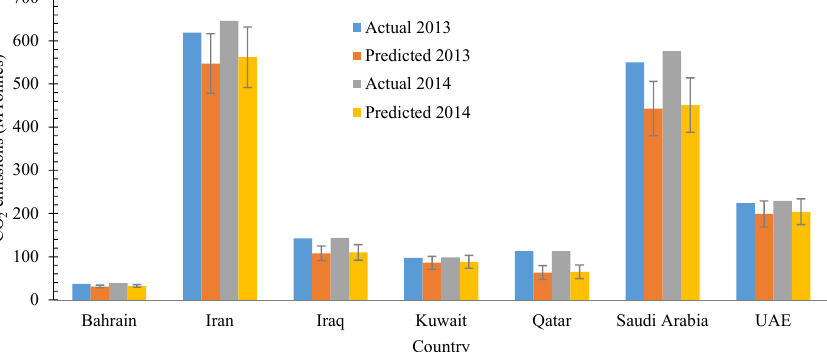
emissions data in the Persian Gulf Countries Fig. 5: Comparing actual and predicted CO 2 2